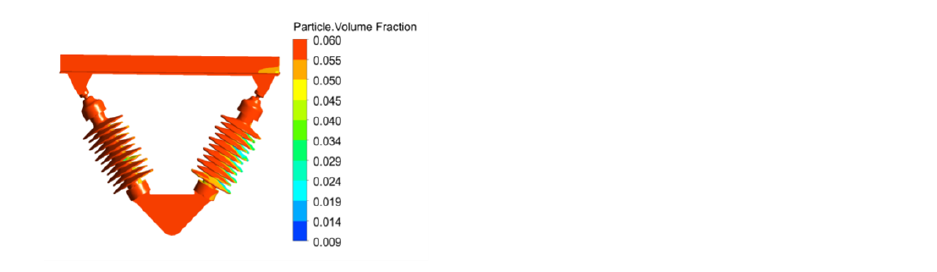
Figure 17. Distribution map of contamination on the surface of insulators with a concentration of 0.04 mg/m 3 .